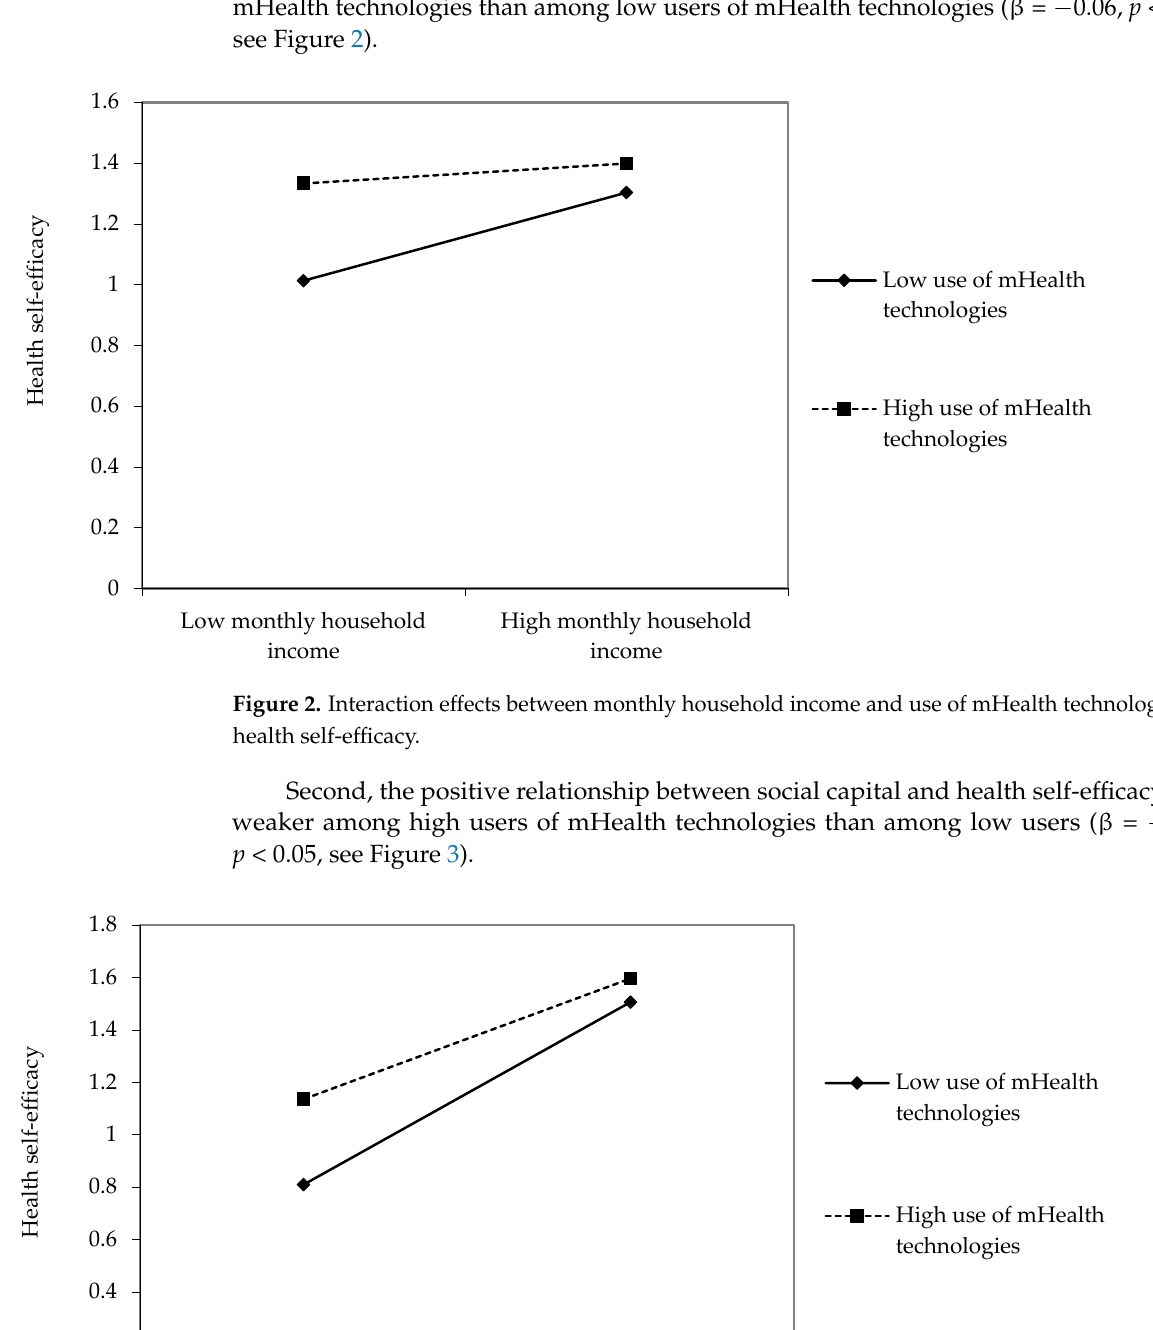
Figure 4. Interaction effects between gender and use of mHealth technologies on health status. Finally, the positive relationship between social capital and health status was weaker among high users of mHealth technologies than among low users of mHealth technolo- gies (β = ‒0.06, p < 0.05, see Figure 5).